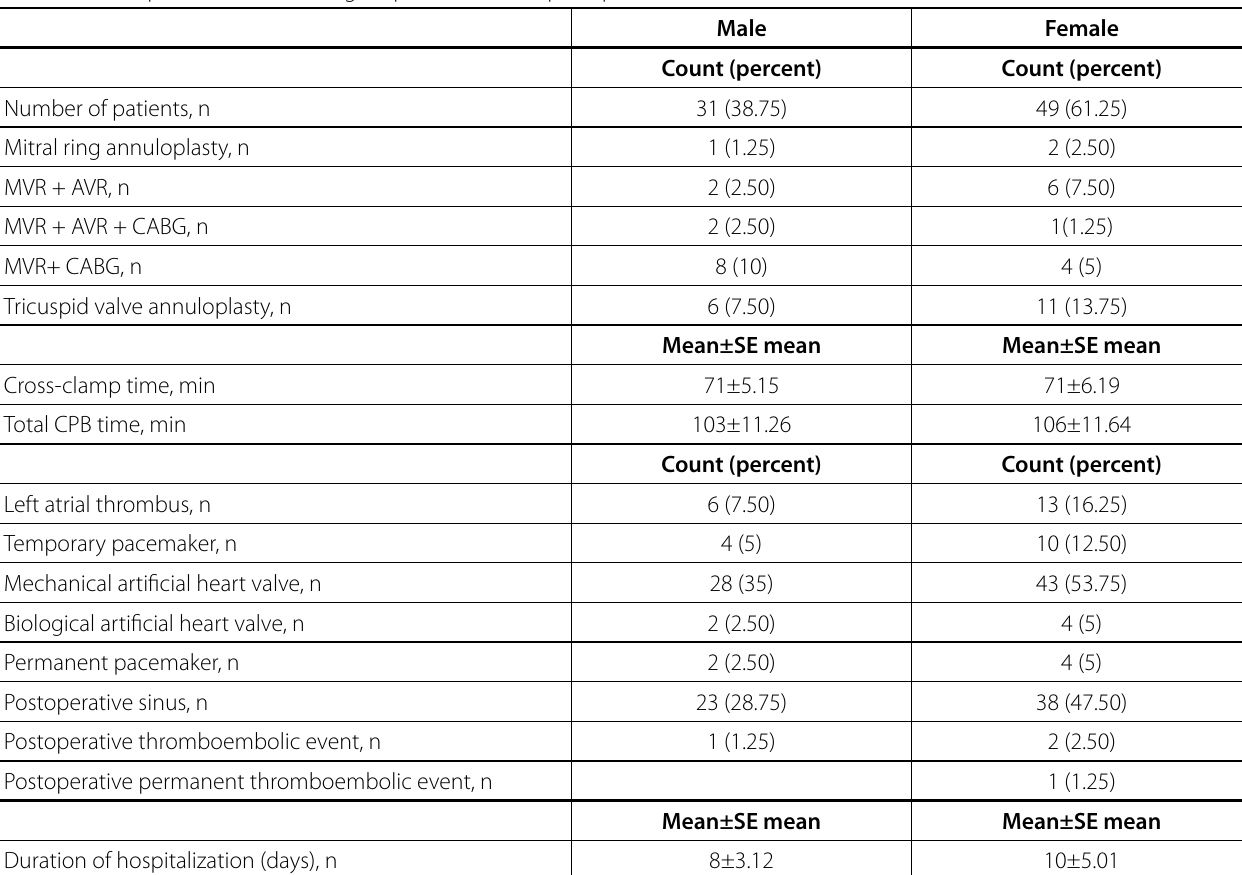
Table 2 . Descriptive statistics for surgical procedures and postoperative